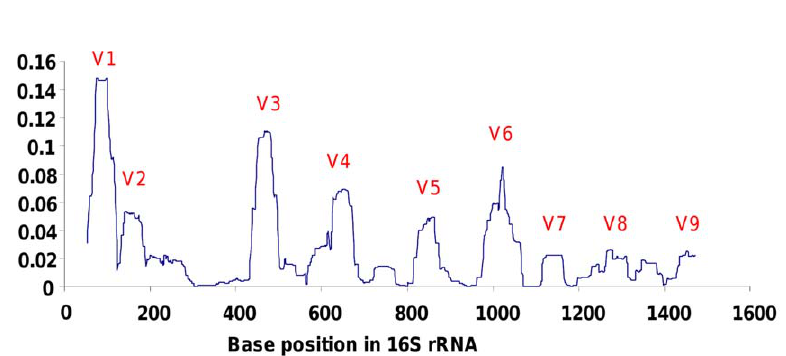
Figure 2. Hypervariable regions within the 16S rRNA gene in Pseudomonas . The plotted line reflects fluctuations in variability amongst aligned 16S rRNA gene sequences of 79 Pseudomonas type strains. Variability for each base position was generated as follows: one minus the frequency of the most common nucleotide residue. The resulting frequency distribution was then smoothed by taking the mean frequency within a 50-base sliding window, moving 1 base position at a time along the alignment. Peaks correspond to the known V1 to V9 hypervariable regions. doi:10.1371/journal.pone.0035647.g002 denaturing gradient gel electrophoresis (DGGE). This method was (Figure 2), we expected that many differences in the 16S rRNA applied by targeting part of the 16S rRNA gene including the V3 genes would be detected by focusing only on this region. For hypervariable region (position 341–534). The primers 341f and example, although most of the different nucleotides in the A1501 534r have been used in many environmental microbiology studies strain are grouped around the V1 region, different alleles should and allow an amplification of the 16S rRNA gene from the whole be detected by our DGGE protocol (data not shown). Bacteria domain [43,44]. Moreover, since the V3 region is the The sequenced genome of the P. putida KT2440 strain also second most variable region of the 16S rRNA gene in Pseudomonas revealed two alleles differing by only one nucleotide in the region